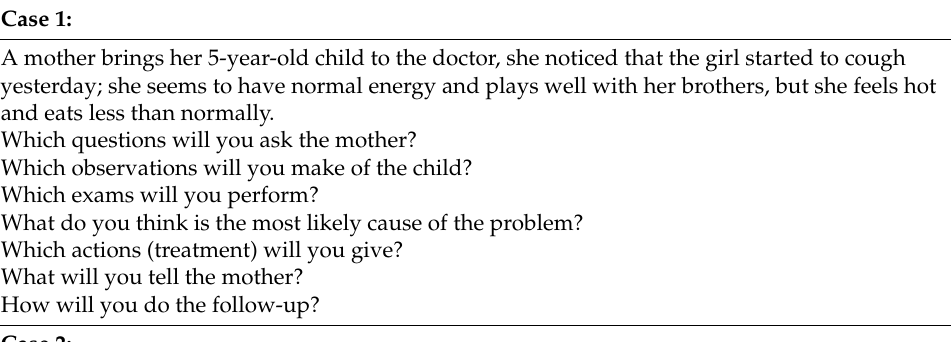
Table 1. Focus group, clinical cases of “children with